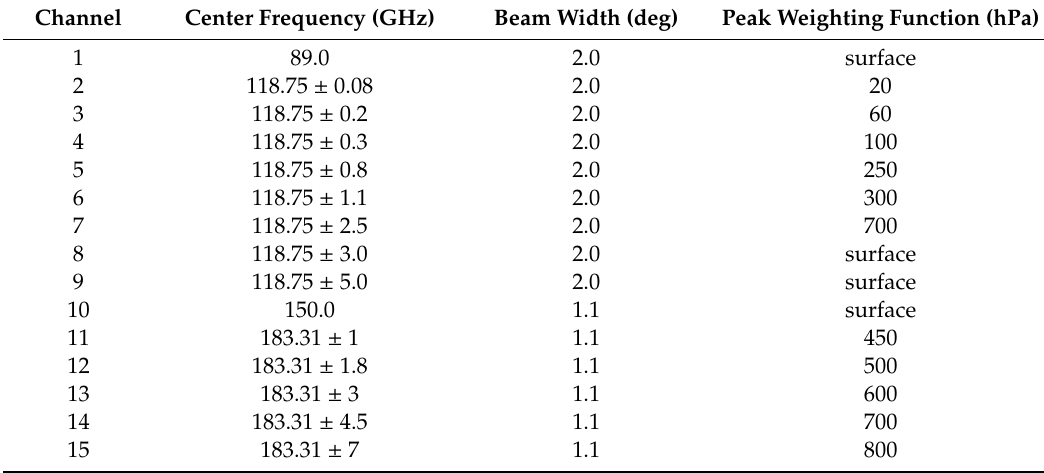
Table 1. Instrument characteristics of the microwave humidity sounder -2 (MWHS-2).